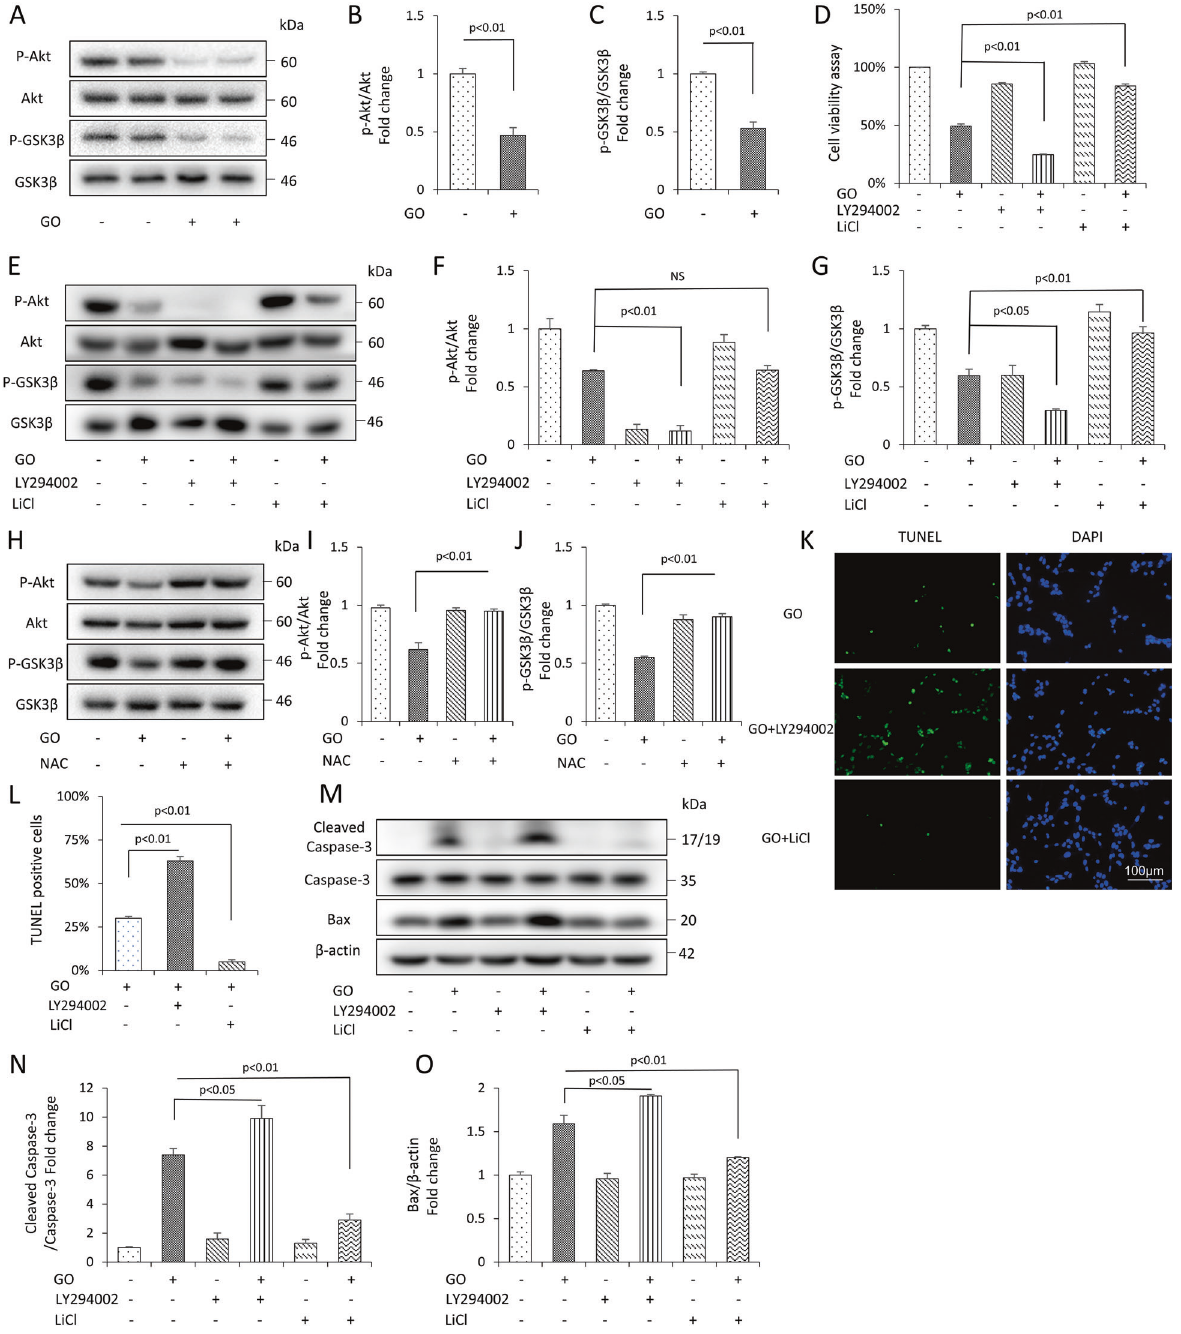
Fig. 5 Involvement of Akt-GSK3 β signaling pathway in glucose oxidase-induced apoptosis in the mDPC6T cells. A – C Protein level of p-Akt and Akt, p-GSK3 β and GSK3 β in the presence of glucose oxidase by Western blot and quanti fi cation analysis. D The cell viability was assessed by CCK8 assays treated with ( + ) or without ( − ) LY294002 or LiCl in the presence ( + ) or absence ( − ) of glucose oxidase. E – G Protein level of p-Akt and Akt, p-GSK3 β and GSK3 β treated with ( + ) or without ( − ) LY294002 or LiCl in the presence ( + ) or absence ( − ) of glucose oxidase by Western blot and quanti fi cation analysis. H – J Protein level of p-Akt and Akt, p-GSK3 β and GSK3 β treated with ( + ) or without ( − ) NAC in the presence ( + ) or absence ( − ) of glucose oxidase by Western blot and quanti fi cation analysis. K , L TUNEL staining and assay. M – O Protein level of cleaved Caspase-3, Bax treated with ( + ) or without ( − ) LY294002 or LiCl in the presence ( + ) or absence ( − ) of glucose oxidase by Western blot and quanti fi cation analysis. The values are expressed as the means ± SD ( n =